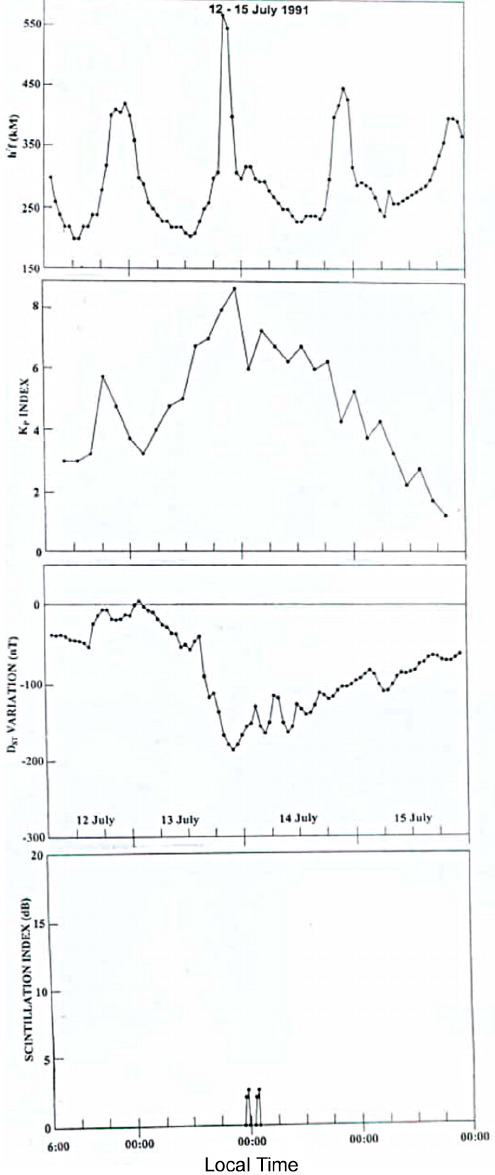
Fig. 12. Example of a magnetic storm that occurred during 12 − 15 July 1991. The top panel is ionospheric F-layer height (h 0 F) at Ahmedabad, the two middle panels are K p and D st and the bot- tom panel shows the occurrence times of scintillation activity at